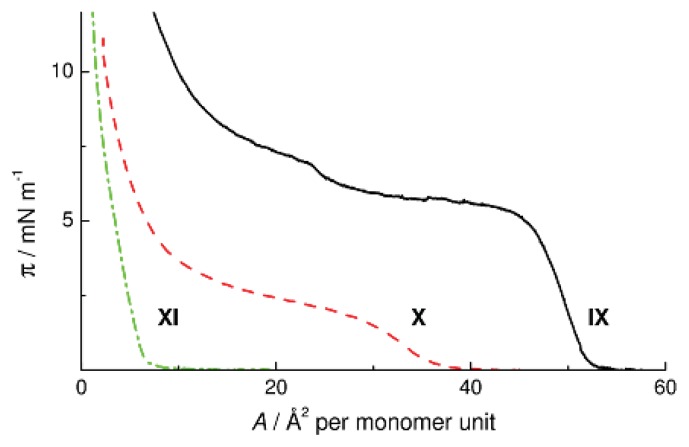
π-A isotherms of CL PMCS IX–XI on water at 20 °C.